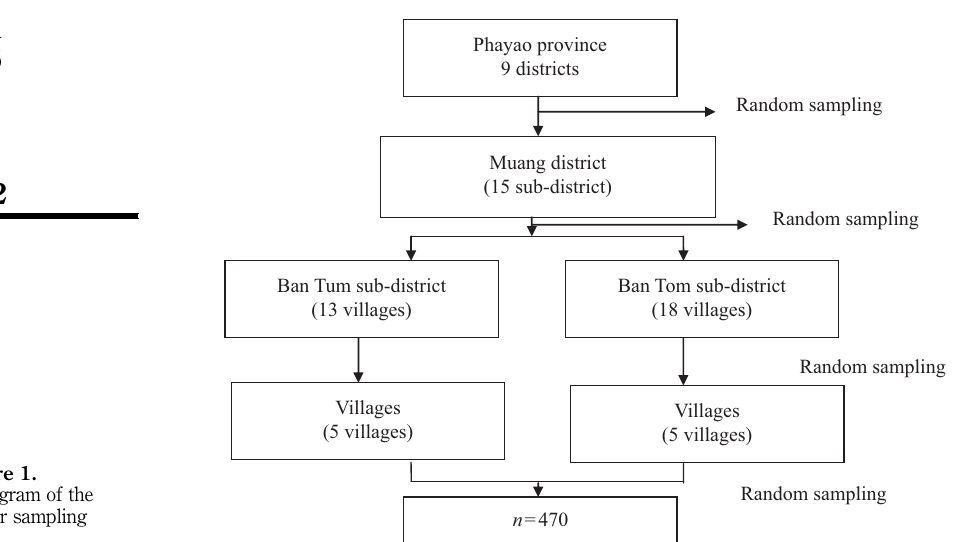
Random sampling